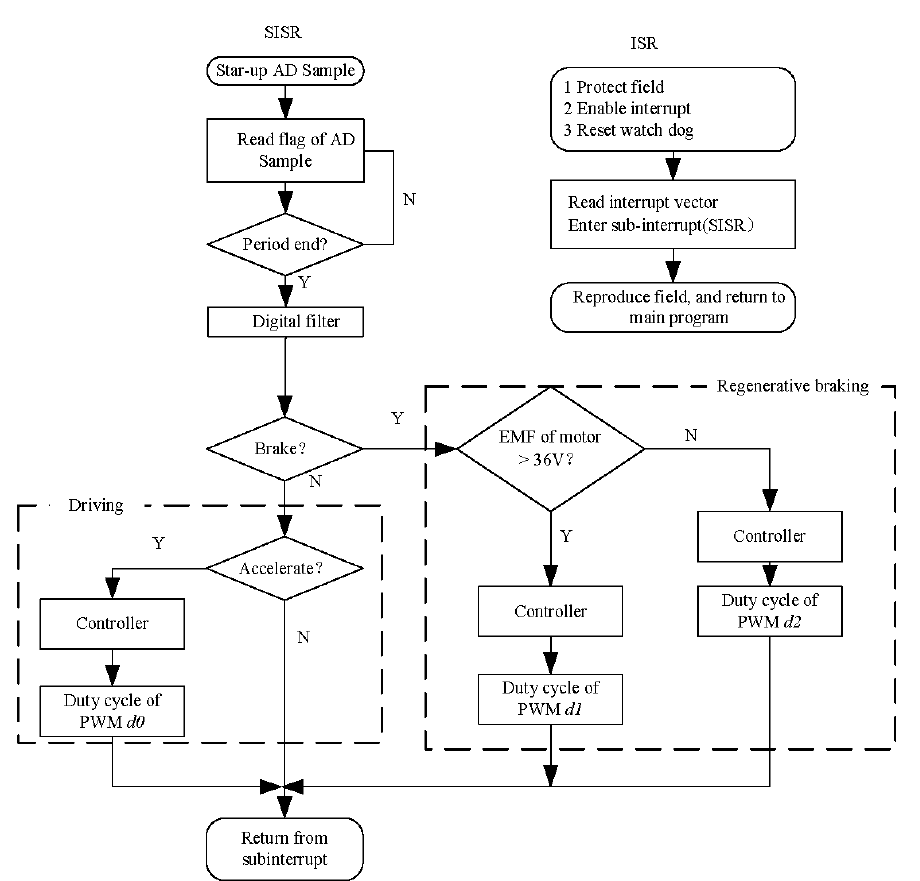
Figure 11. The configuration of the controller